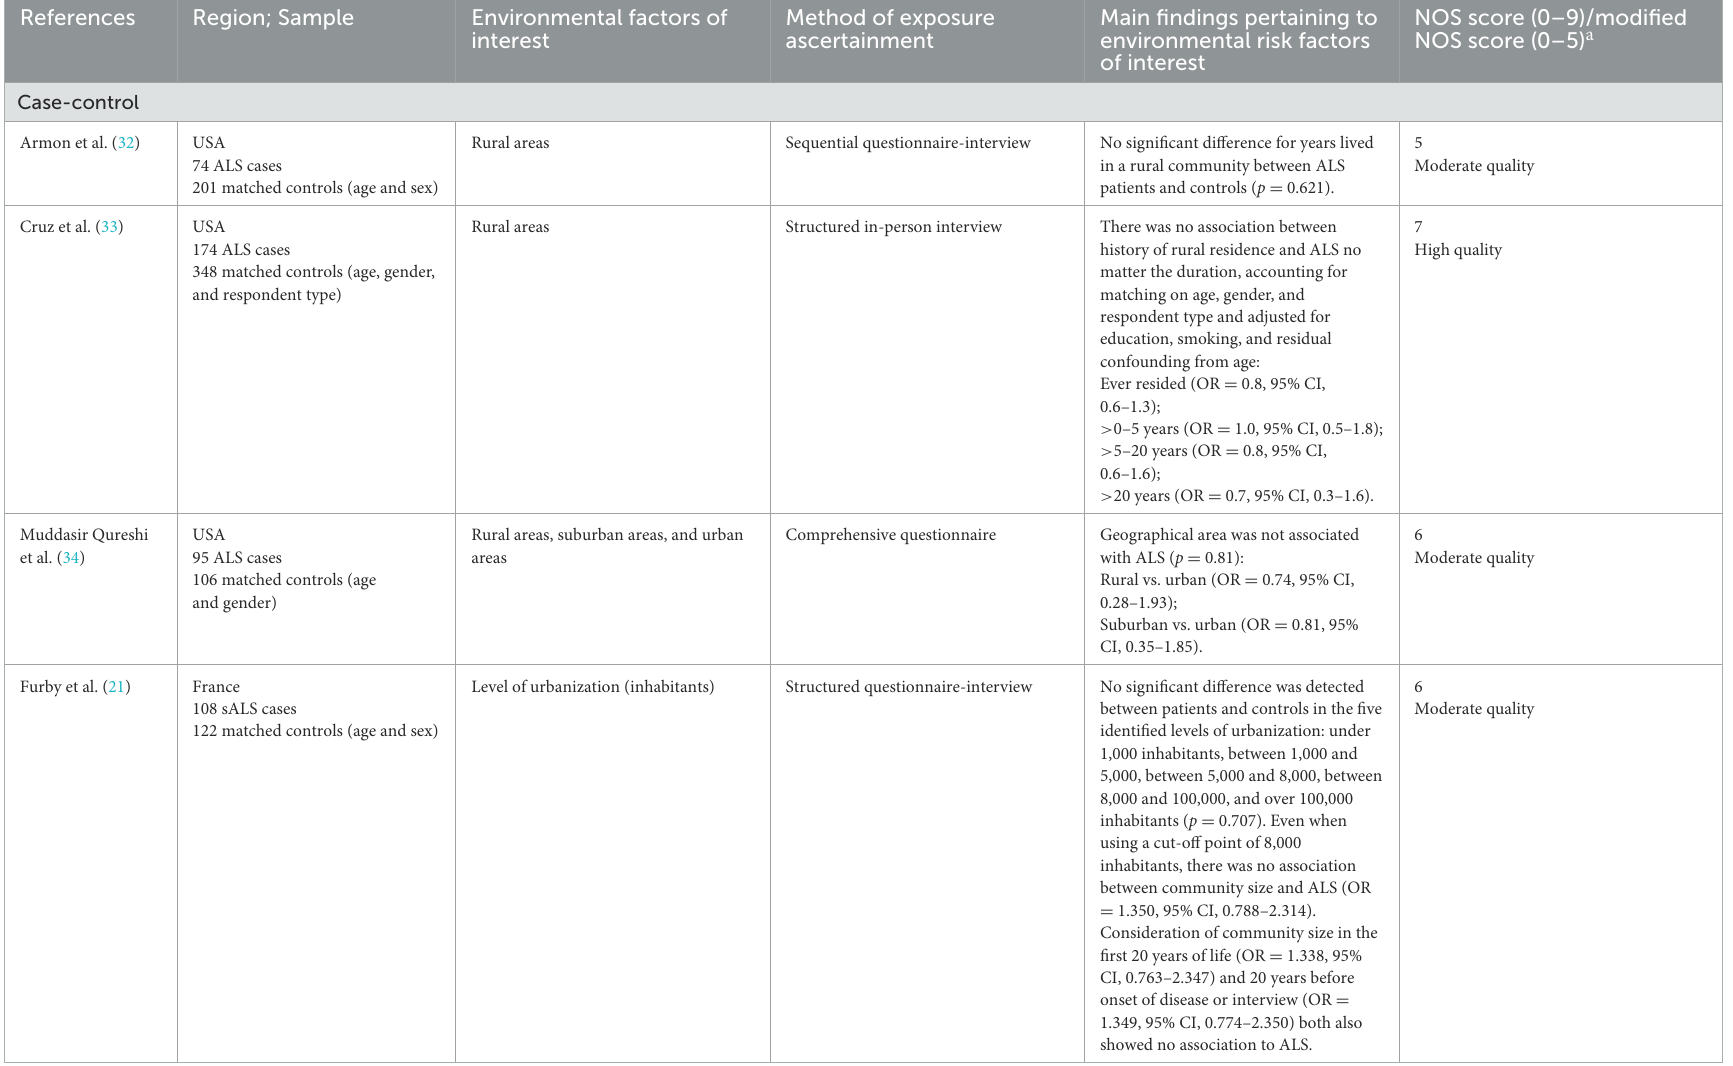
TABLE 2 Description of 25 included urbanization